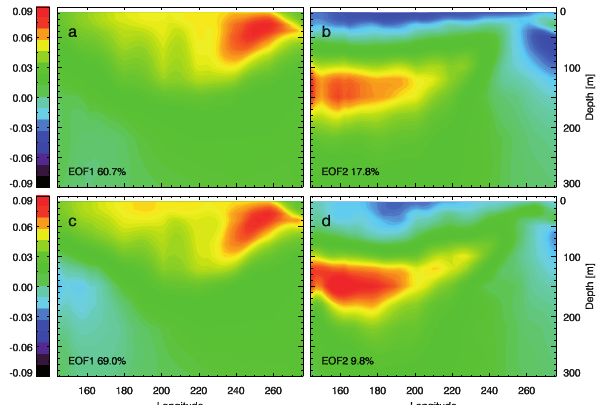
Fig. 2. First and second EOFs of temperature computed from an equatorial slice in the Pacific Ocean for the unperturbed simulation (a, b), and for the bred experiment (c, d). The numbers on the plots indicate the explained variance of the respective EOF pattern.